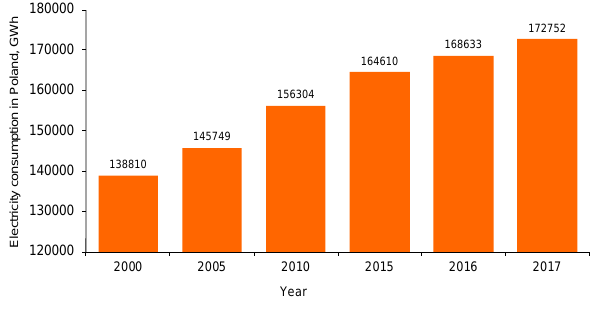
Fig. 1. Electricity consumption in Poland in the years